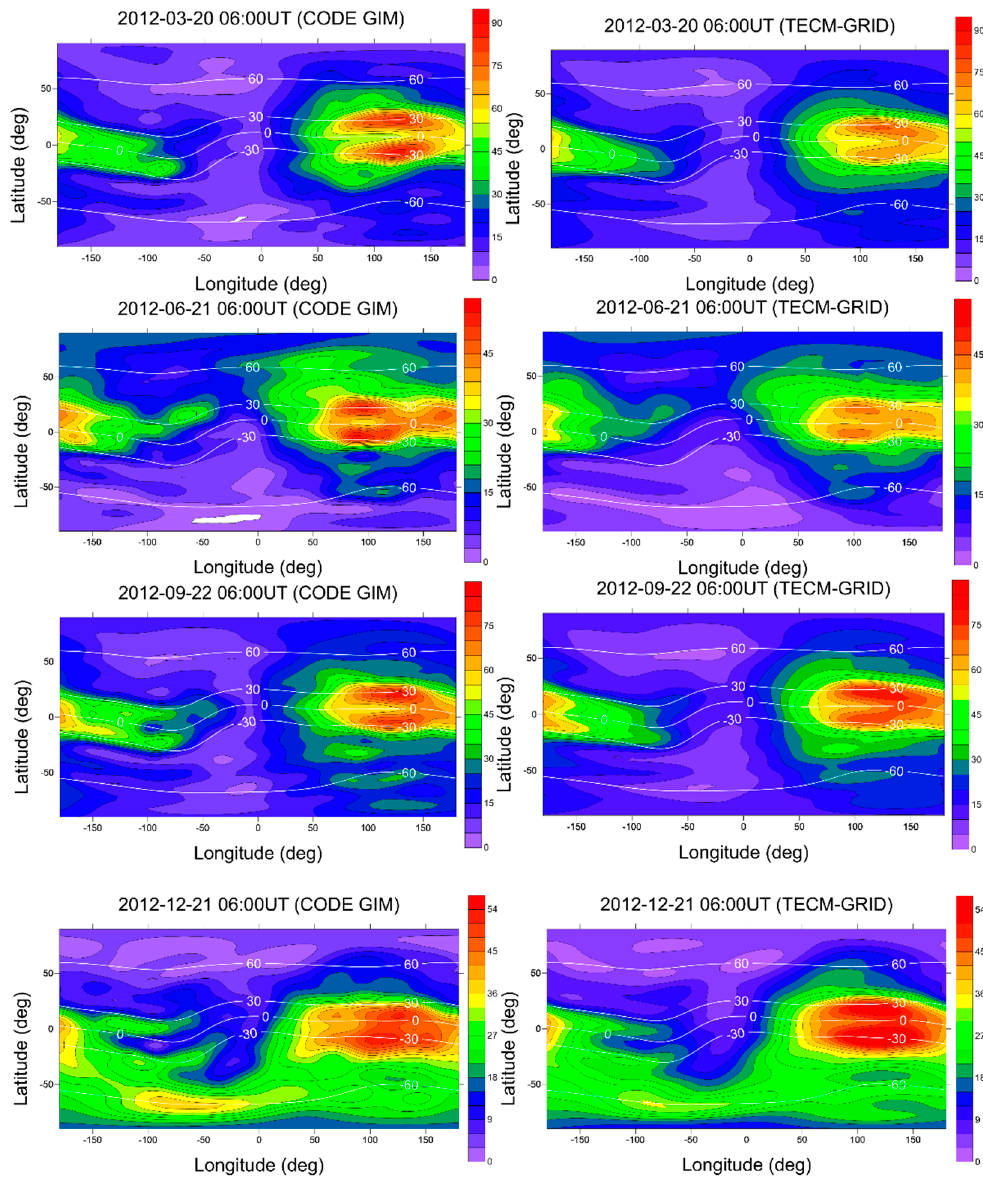
Figure 6. Comparison of CODE GIMs and TECM-GRID models (2008).